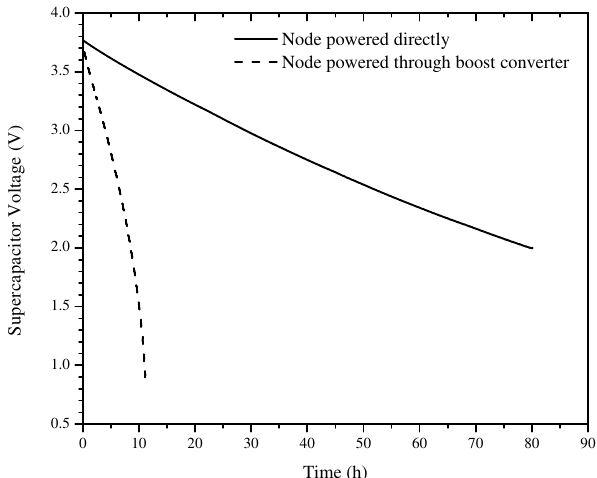
Figure 11. Voltage across the backup storage while operating in total darkness (transmission every 200s).